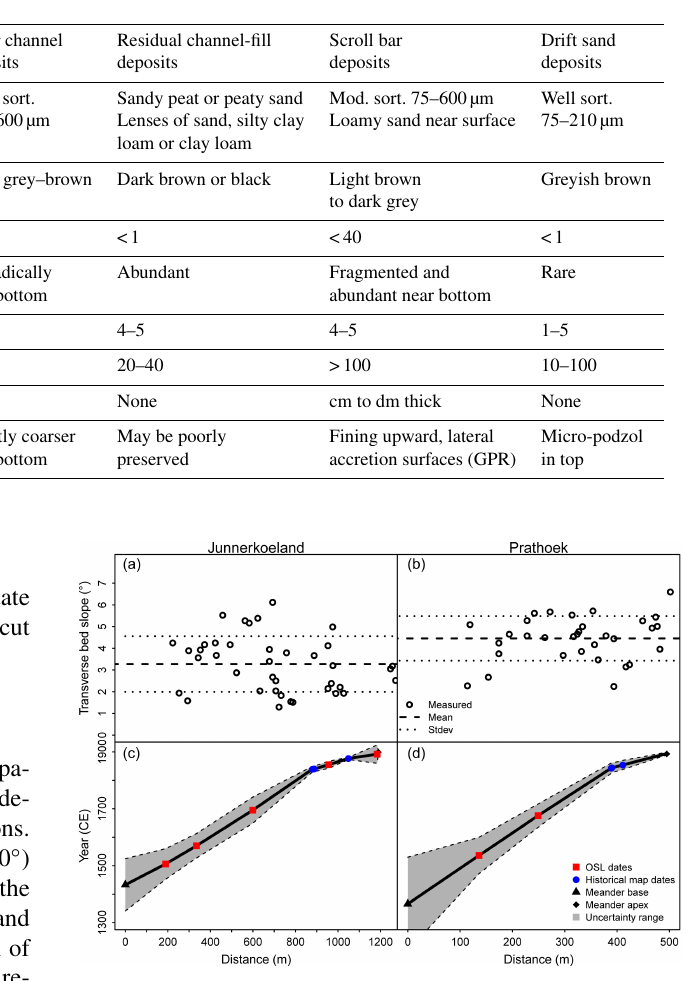
Figure 7. Transverse bed slope derived from GPR cross sections from the inner point bar to the outer bend for Junnerkoeland (a, c) and Prathoek (b, d) as well as lateral migration distance plotted against age for both bends. Panels (a) and (b) show the transverse bed slope of lateral accretion surfaces measured in the GPR profile (example in Fig. 4), including the mean and standard deviation of all measurements. Panels (c) and (d) show the relation between age and migration distance of the bends. Shading indicates standard de- viation of the Bayesian deposition model determined by Quik and Wallinga (2018) for the OSL and historical map